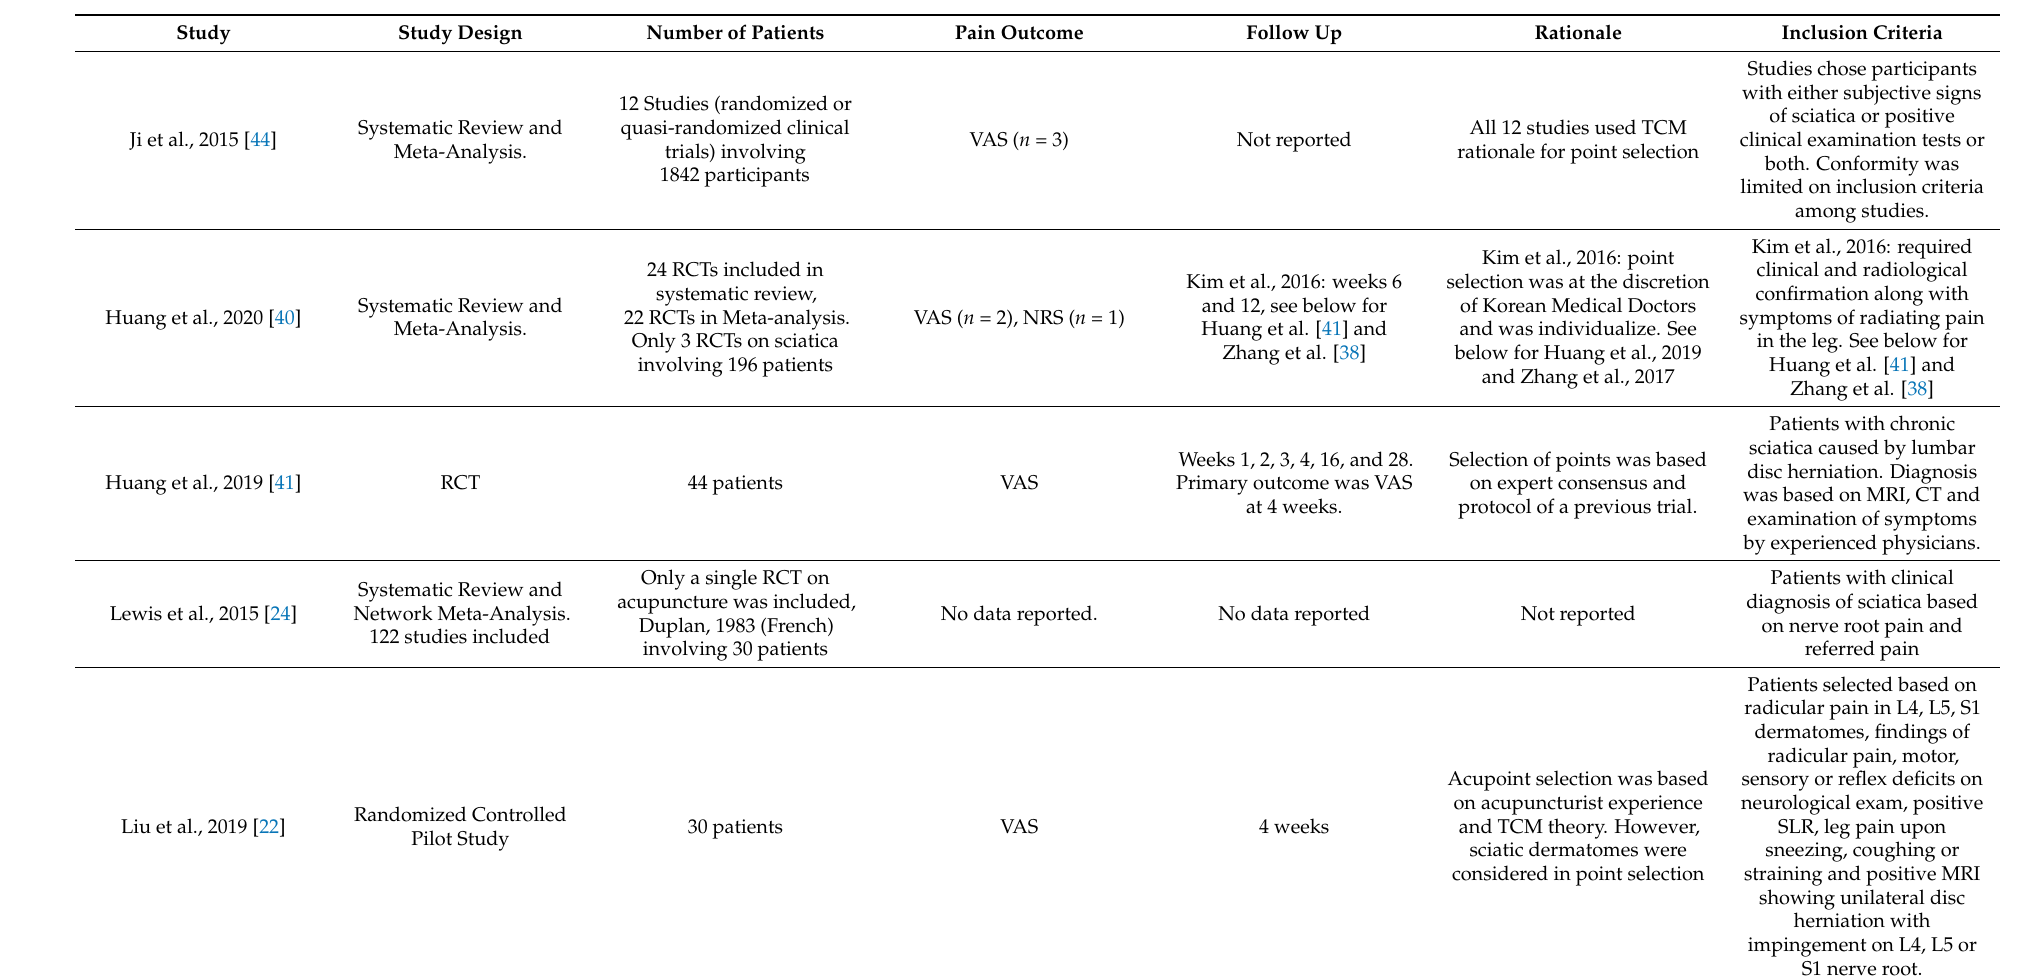
Table 3. Description of included